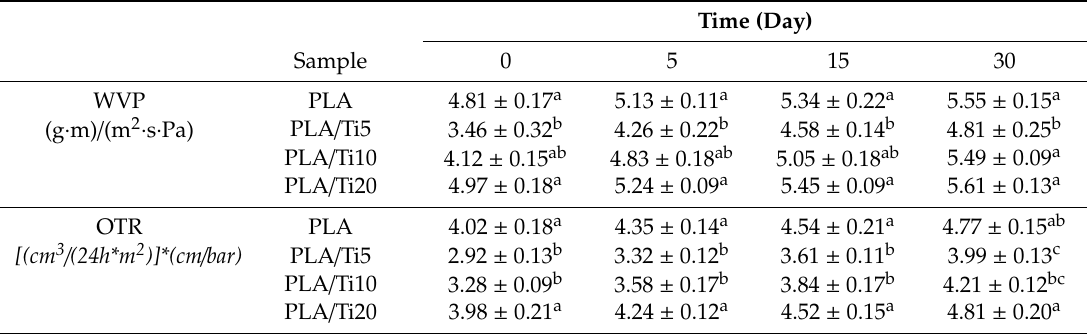
Table 4. Water vapor permeability (WVP) and oxygen transmission rate (OTR) of PLA / nano-TiO 2 composite films after high pressure